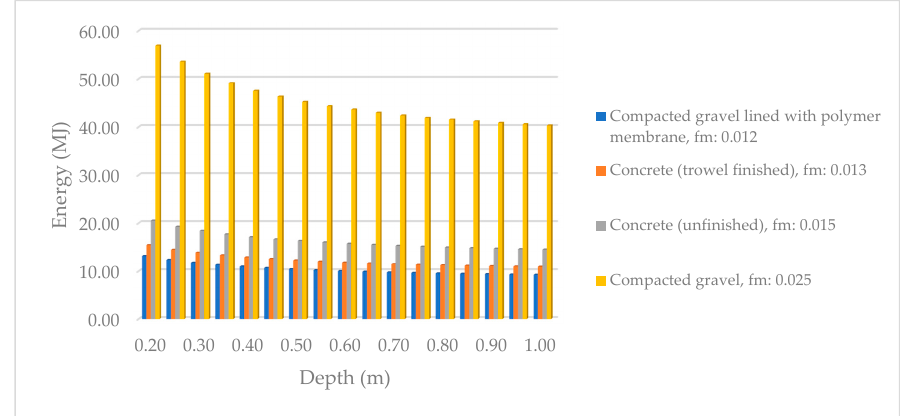
Figure 6. Energy requirements for operating the paddlewheel with different culture depths and pond materials (18 h).